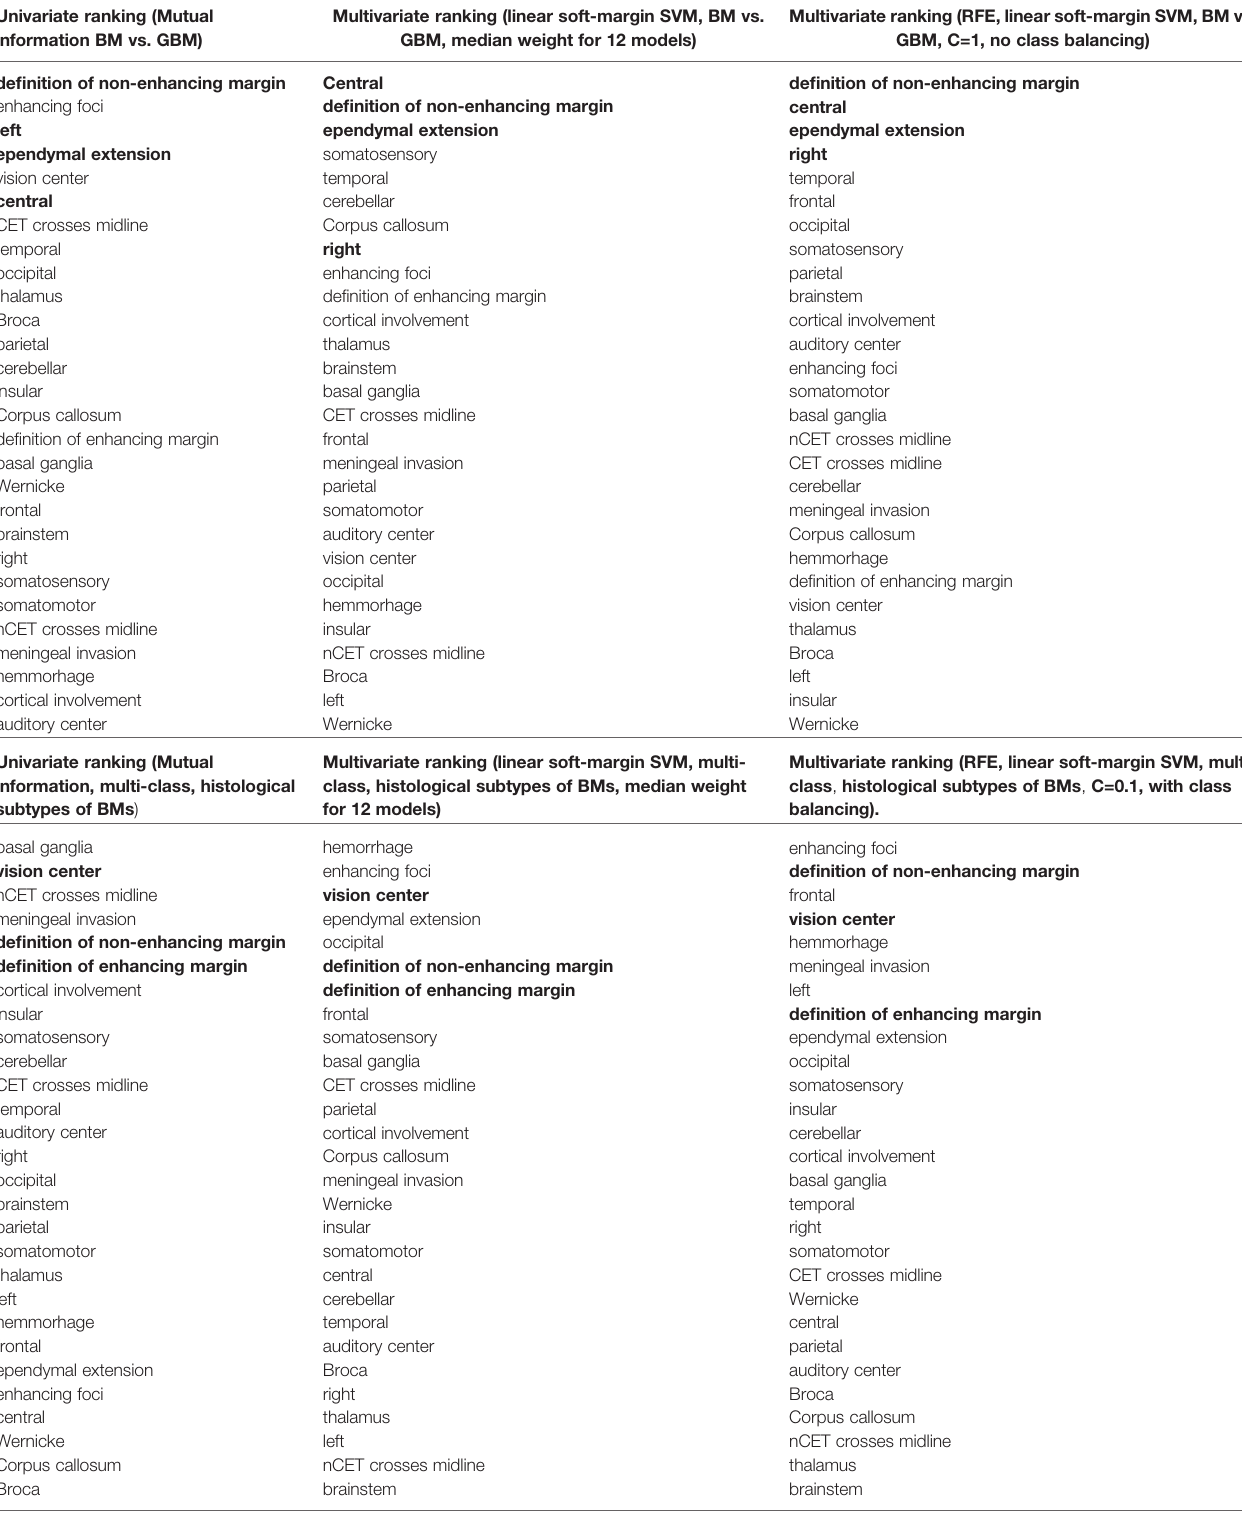
TABLE 3 | Results of univariate and multivariate feature ranking (repeated fi tting or recursive feature elimination) for differentiation of brain metastases (BM) from glioblastoma (GBM) as well as the differentiation of the four different histological BM subtypes (mammacarcinoma, NSCLC adenocarcinoma, NSCLC SCC, SCLC). Univariate ranking (Mutual information BM vs.